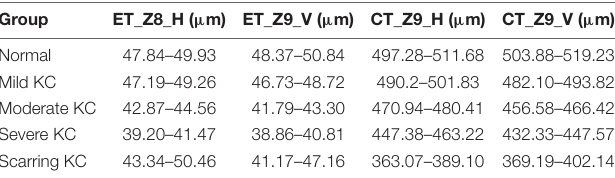
TABLE 3 | A 95% CI of epithelial thickness and corneal thickness in selected